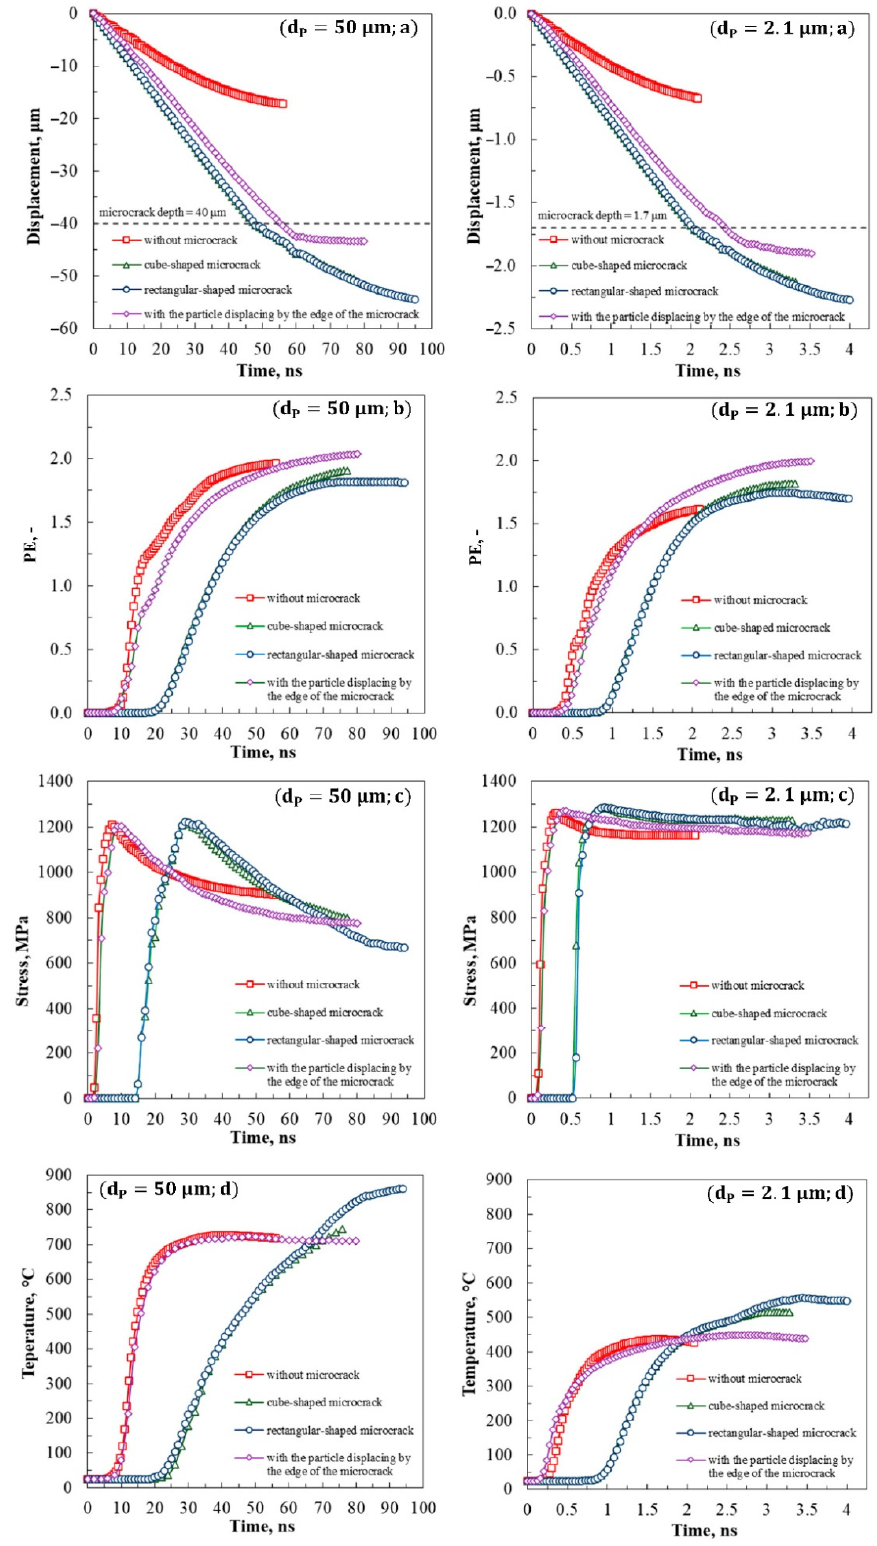
Figure 10. Time evolution of ( a ) penetration depth; ( b ) maximum plastic strain; ( c ) maximum von Mises stress; ( d ) maximum temperature in particles of different sizes: left diagrams show the results for d P = 50 µ m, right diagrams present the case of d P = 2.1 µ